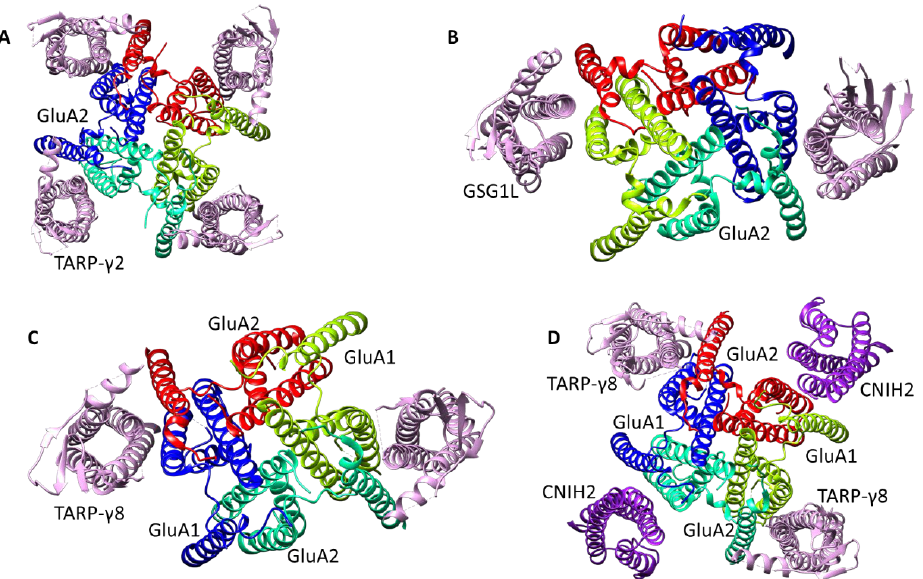
Figure 3. Representative examples of experimentally determined structures of AMPA receptor complexes with auxiliary subunits. ( A ) GluA2 + 4 TARP- γ2 (PDB: 5VOT), ( B ) GluA2 + 2 GSG1L (PDB: 5WEM), ( C ) GluA1/2 + 2 TARP- γ8 (PDB: 6QKZ), ( D ) GluA1/2 + 2 TARP- γ8 + 2 CNIH2 ( PDB: 7OCA).